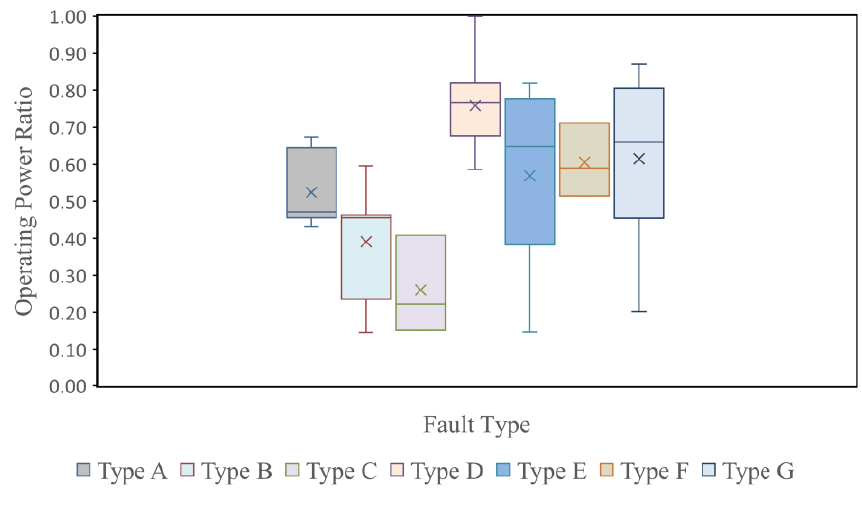
Figure 4. Box plot of operating power ratio for different fault types.